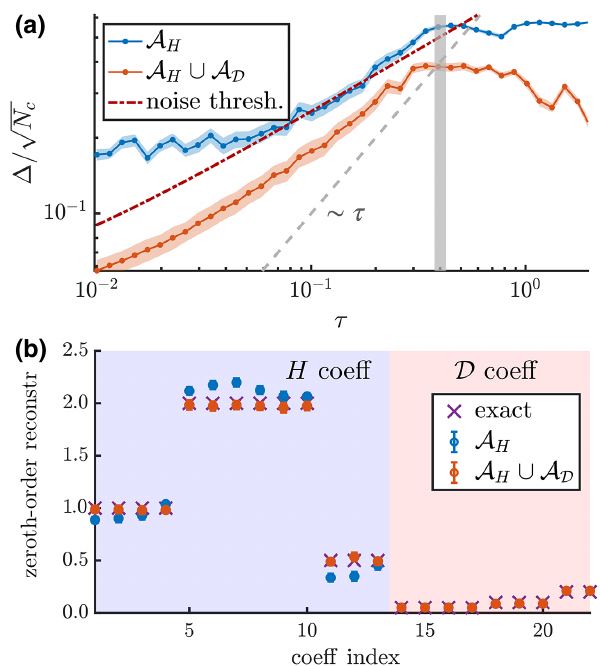
FIG. 7. Floquet Liouvillian learning. FLL in a dissipative DQS of the Heisenberg- XXZ model for N = 4 spins. (a) The behavior of (cid:11)(τ) for a zeroth-order ansatz without (blue) and with (red) dissipative terms. The error bars stem from a finite measurement budget per operator of n s = 1000. The dashed red line gives an upper bound to (cid:11)(τ) from measurement noise. The dashed gray line is a guide to the eye that shows scaling linear in τ . (b) Recon- structed parameters for both cases (blue and red dots) together with the exact values (purple crosses). Hamiltonian parameters are defined in Eq. (14): B x = 1 (indices 1–4), J xx = J yy = 2 (indices 5–10), J z = 0.5 (indices 11–13). Dissipation rates [Eq. = 0.05 (indices 21–22). The learned dissipation rates are 4 times their values in L i , because dissipation acts dur- ing the application of all gates, which are four in the present example [see Eq. (15)]. The constraint operators are chosen to , ˆ σ y , ˆ σ z for a number of 20 be all single-spin Pauli operators ˆ σ x i i i random initial product states each. The discretization of the inte- gral in Eq. (26) is chosen to be τ up to a fixed total simulation time T =